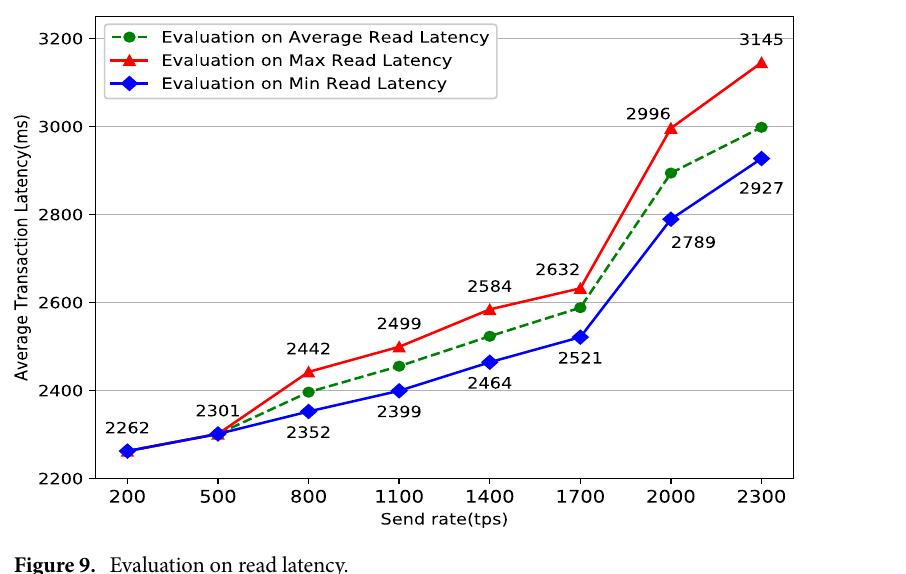
Figure 9. Evaluation on read